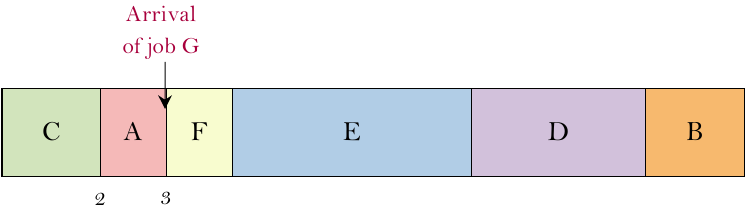
Figure 5. Disruption caused by job G arrival.